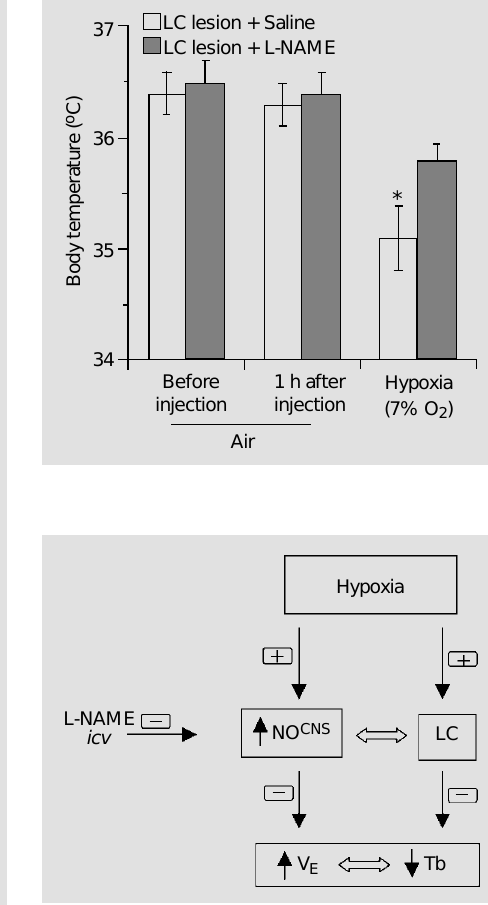
Figure 8 - Possible mechanisms through which the locus coeru- leus (LC) and nitric oxide (NO) could mediate hypoxia-induced hyperventilation and hypother- mia. Hypoxia leads to an in- crease in NO in the CNS and in the firing rate of LC neurons, which cause an increase in pul- monary ventilation (V E ) and a re- duction in body temperature (Tb). N G -nitro-L-arginine